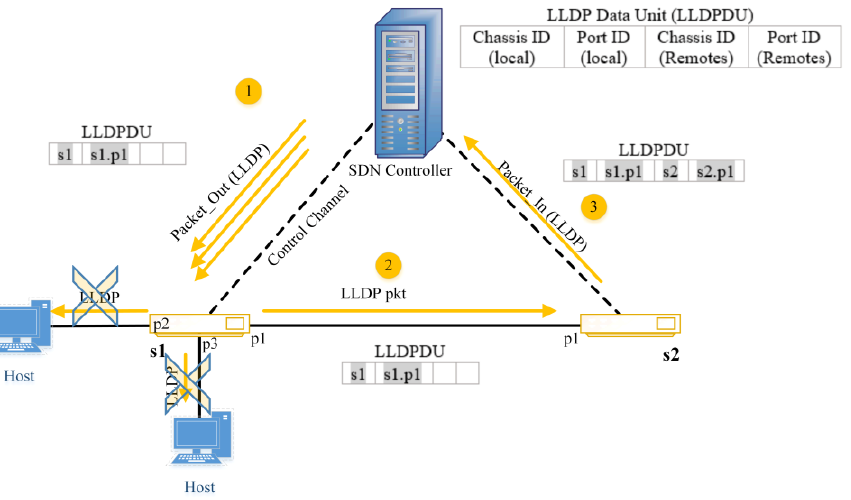
Figure 9. ESLD methodology.